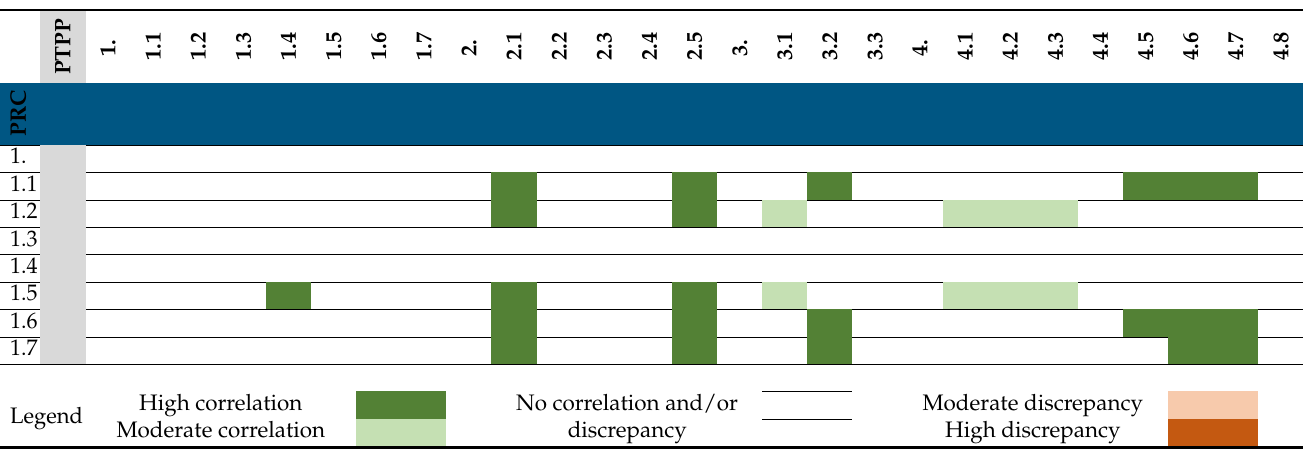
Table 17. Correlation matrix between the objectives of the PTPP of the PRG Revision and the objectives of the City’s Climate Resilience Plan